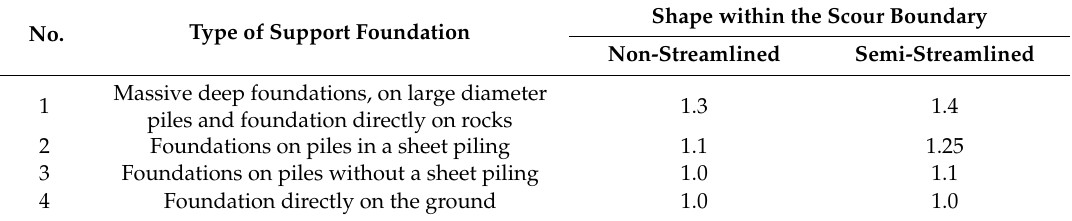
Table 4. Permissible scour degree [11].